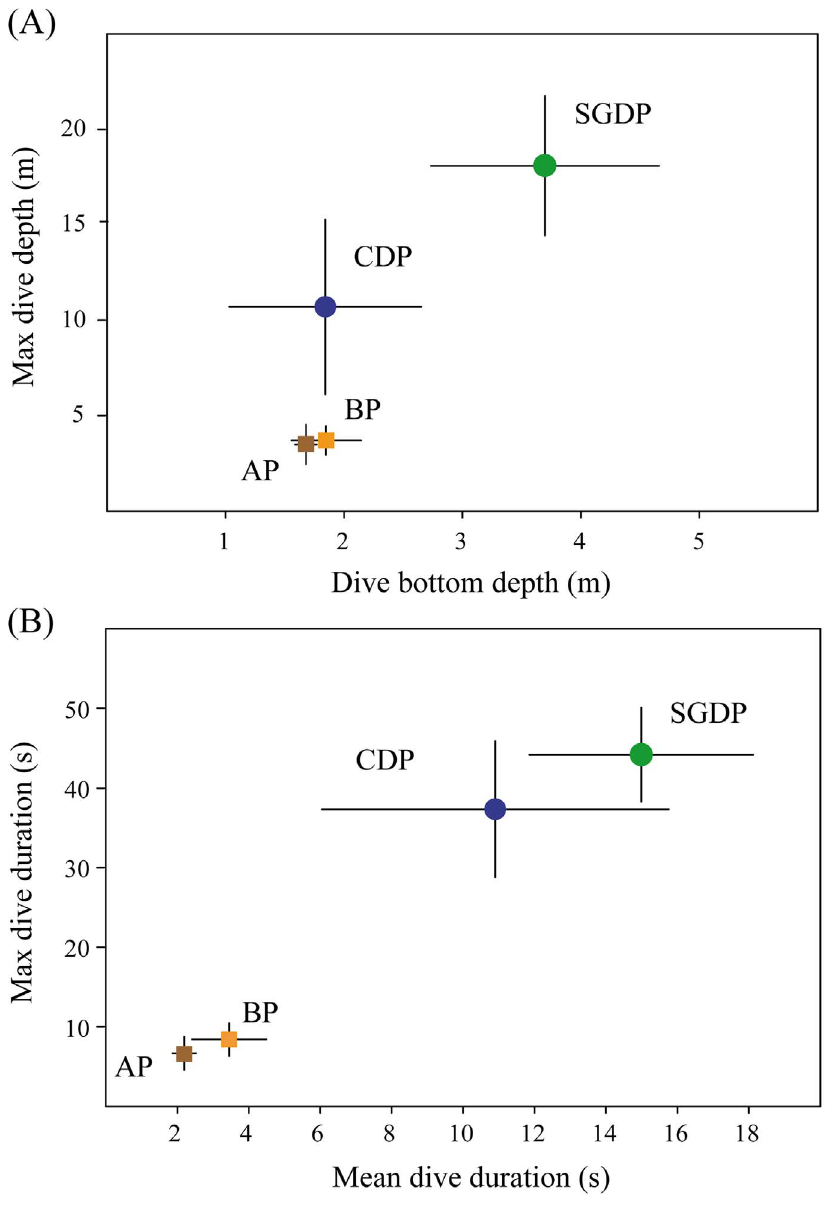
Figure 3. Diving capability descriptors. Mean and standard deviation of (a) maximum dive depth and bottom dive depth, and (b) maximum dive duration and mean dive duration of 19 common diving petrels (CDP), 6 South Georgian diving petrels (SGDP), 3 Antarctic prions (AP) and 5 blue petrels (BP) fitted with TDRs during incubation at Bird Island, South Georgia in summer 2010/11.